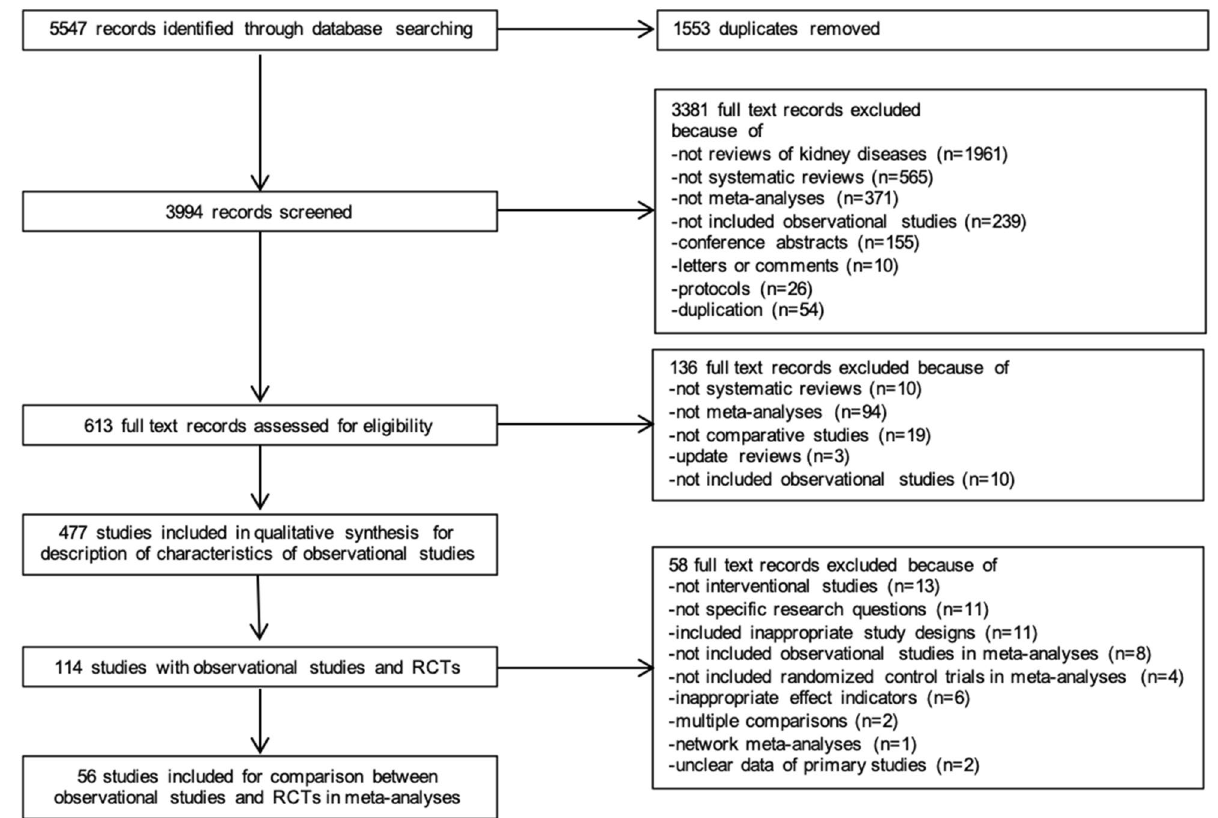
Figure 1. Study flow diagram and study selection